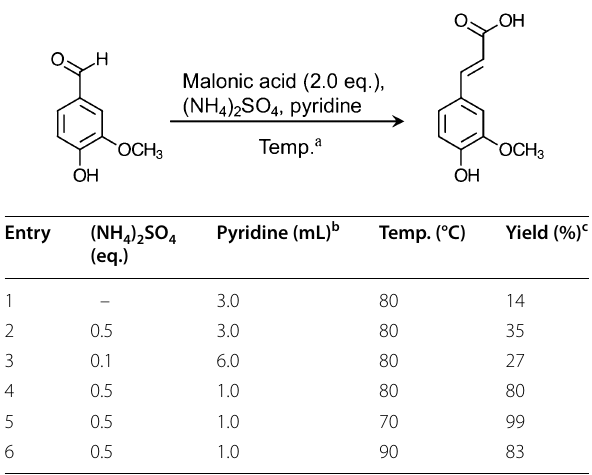
Table 1 Optimization of the Knoevenagel–Doebner reaction conditions under (NH